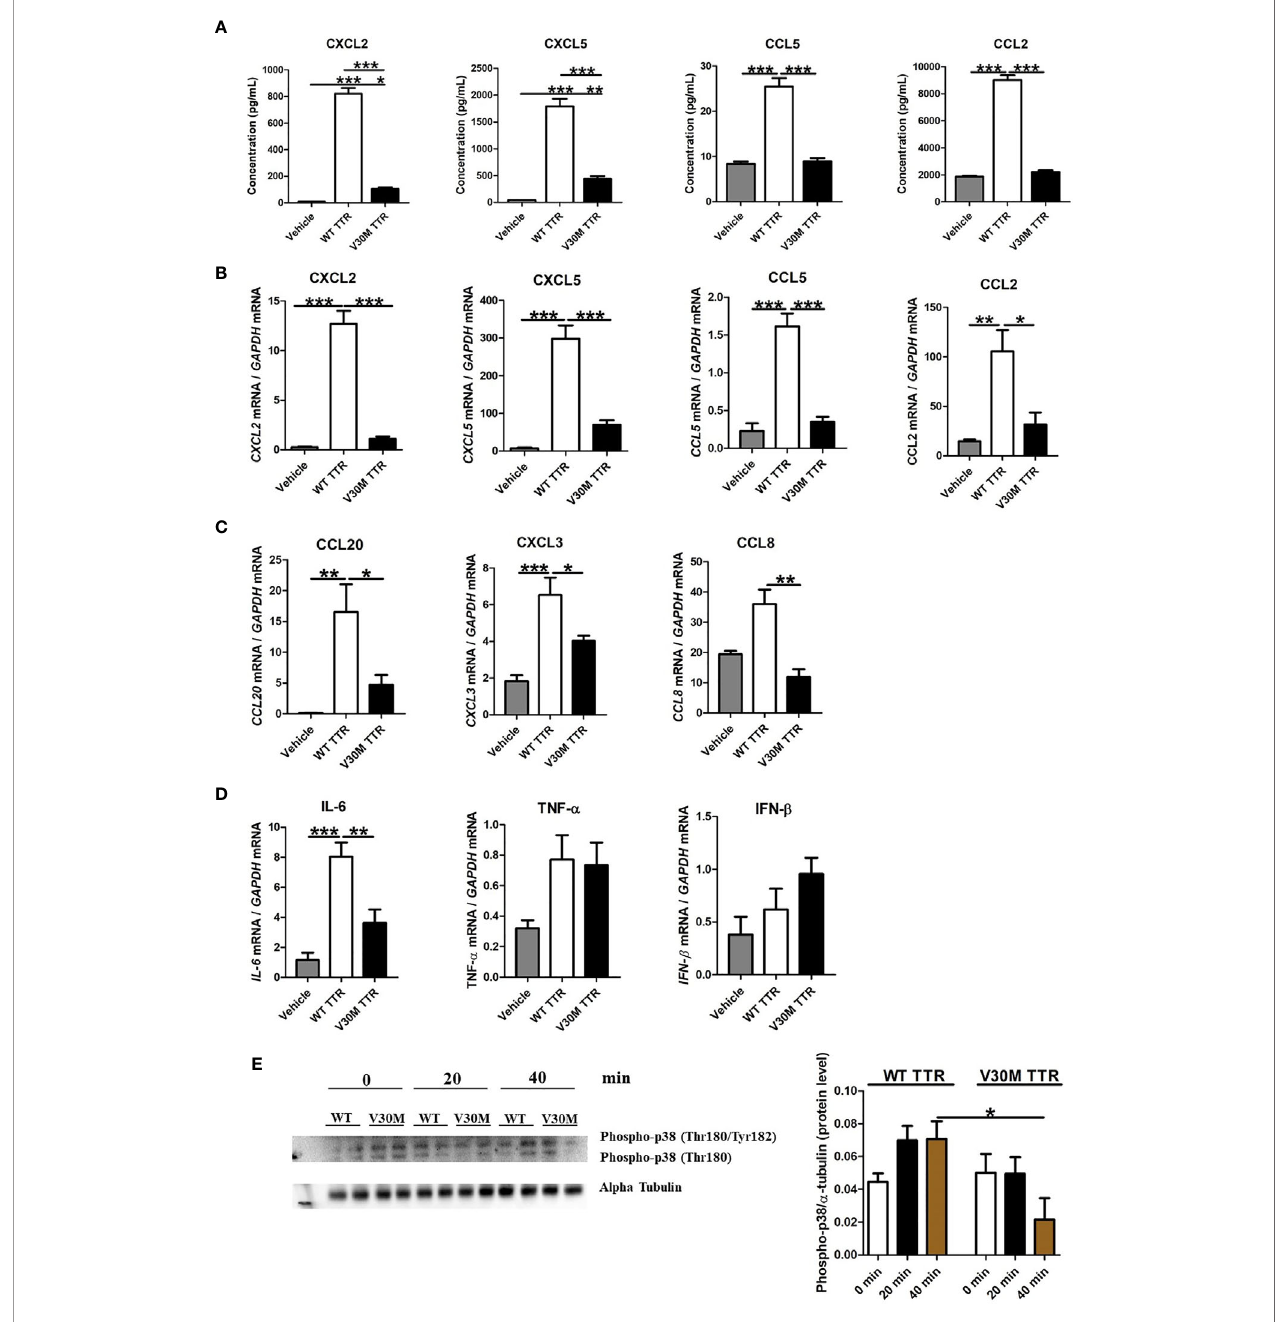
FIGURE 2 | The expression of chemokines were downregulated in Schwann cells incubated with V30M TTR. (A) A Luminex analysis showed a decreased expression of chemokines in SCs incubated with V30M TTR when compared with SCs incubated with WT TTR for 24 hours. (B) RNA was extracted from SCs incubated with WT and V30M TTR and the levels of chemokines were found highly downregulated with V30M TTR incubation. (C) Reduced levels of CCL20, CCL8 and CXCL3 were determined by RT-PCR in SCs incubated with V30M TTR when compared to WT TTR. (D) The expression of cytokines were assessed by RT-PCR in SCs incubated with WT or V30M TTR. (E) Western blot analysis for the phosphorylation of p-38 in SCs incubated with WT or V30M TTR at different time points. Were observed two forms of Phospho-p38 corresponding to Phospho-p38 MAP Kinase dually phosphorylated at threonine 180 and tyrosine182, and with Phospho-p38 singly phosphorylated at Thr180. Data were analyzed using one-way ANOVA followed by Bonferroni post-test and represented as mean ± s.e.m (*P < 0.05; **P < 0.01; ***P <